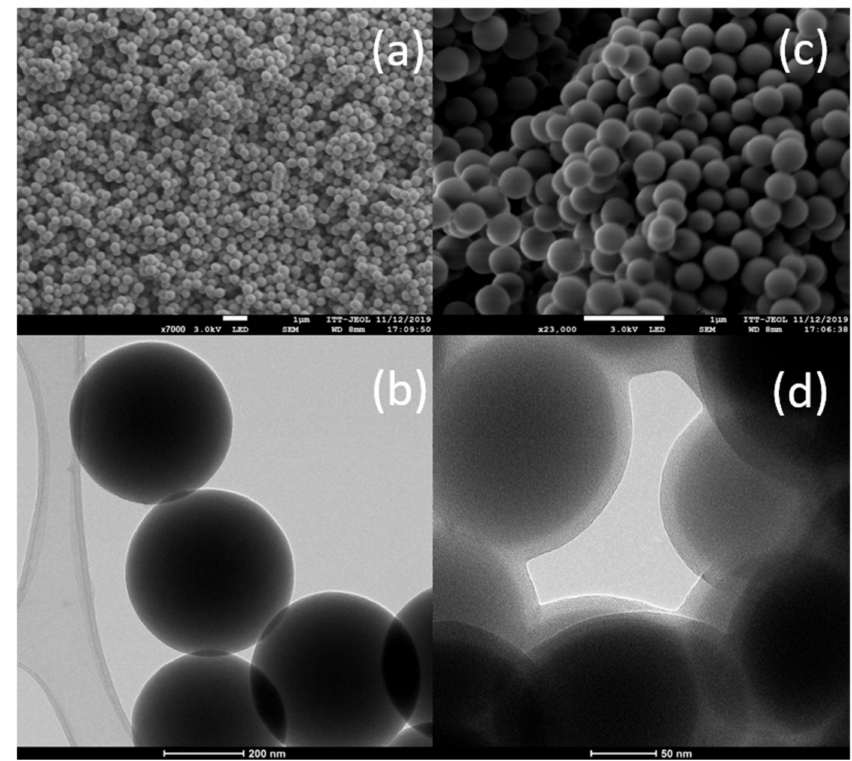
Figure 6. FESEM images ( a , c ) of bare silica nanospheres and HRTEM images ( b , d ) of mesoporous silica loaded with Albendazole and coated with